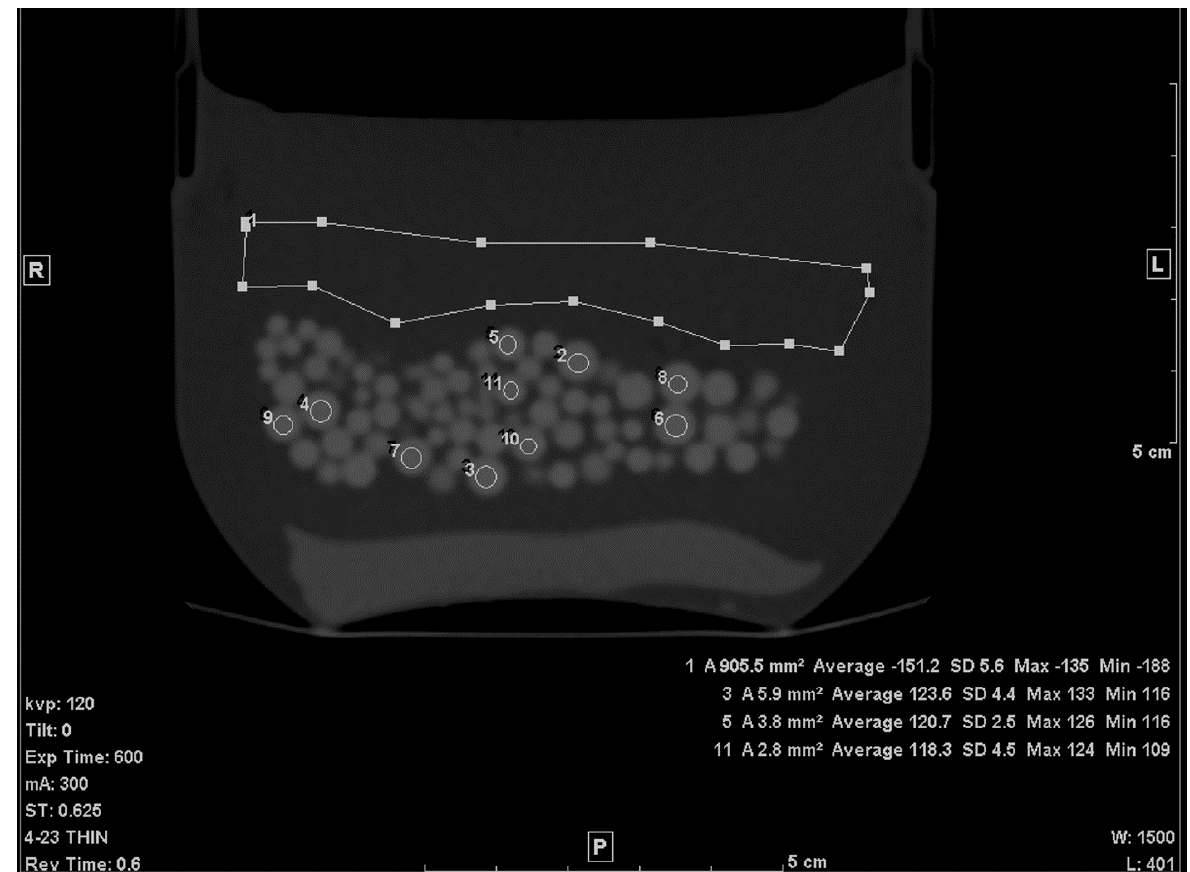
Figure 1. A thin slice (0.625mm) of the scanned phantom with ROIs to determine average CT# of Lucite beads and Vaseline. The second step was to draw an ROI in each of the slices that included any portion of the beads. A freehand ROI drawing option was used to ensure that no other pixels other than the jelly and the beads were included, as seen in Figure 2. For each slice, the mean density in Hounsfield units (HU), standard deviation (SD), and the area of the ROI in mm 2 were shown on the workstation image. Both the mean density and area were